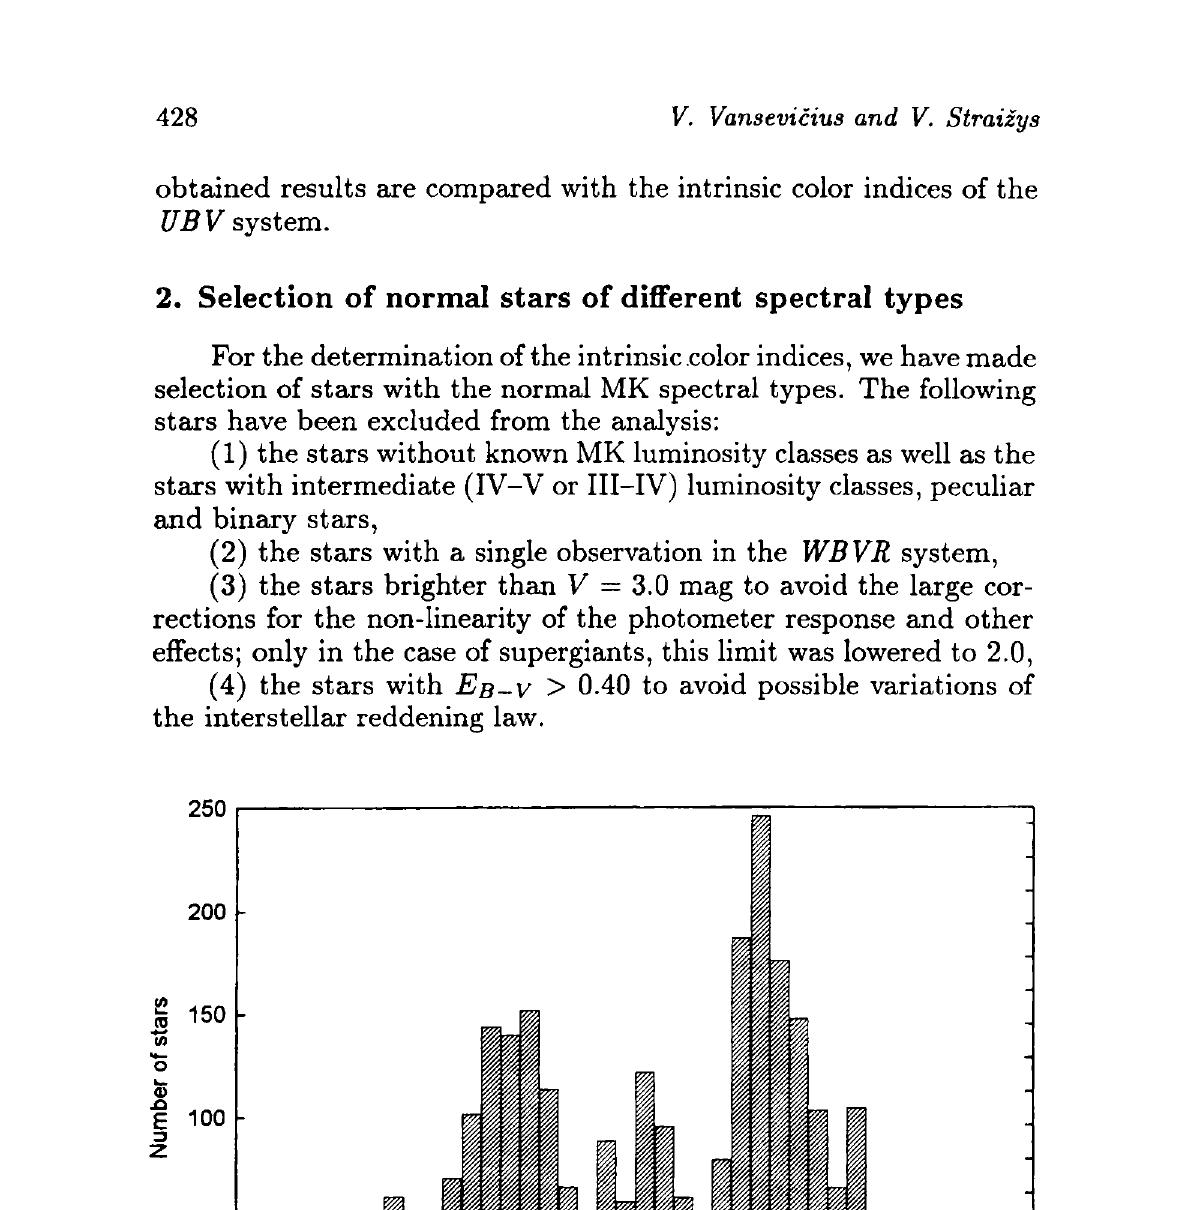
Fig. 1. Distribution of the used stars in spectral